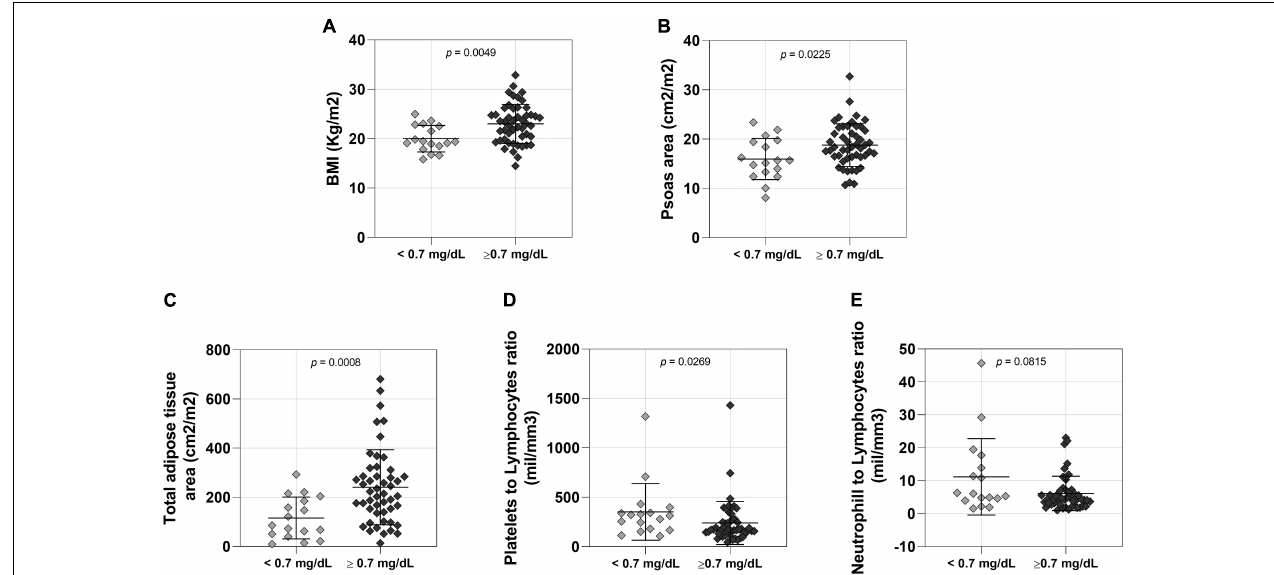
FIGURE 1 | Comparison between lower ( n = 17 < 0.7 mg/dL) and normal ( n = 49 > 0.7 mg/dL) creatinine level male patients. (A) BMI: body mass index; < 0.7 mg/dL 57.53 ± 9.234 (mean ± SD), > 0.7 mg/dL 67.37 ± 13.03 (mean ± SD); 95% CI 0.9478–5.077. (B) Psoas area ; < 0.7 mg/dL 15.96 ± 4.187 (mean ± SD), > 0.7 mg/dL 18.79 ± 4.340 (mean ± SD); 95% CI 0.4132–5.2520. (C) Total adipose tissue ; < 0.7 mg/dL 116.0 ± 85.25 (mean ± SD), > 0.7 mg/dL 240.9 ± 152.5 (mean ± SD); 95% CI 43.50–172.6. (D) Platelets to lymphocytes ratio ; < 0.7 mg/dL 353.2 ± 286.7 (mean ± SD), > 0.7 mg/dL 240.4 ± 217.9 (mean ± SD); 95% CI –164.9 to –7.320 (E) Neutrophill to lymphocytes ratio ; < 0.7 mg/dL 11.17 ± 11.60 (mean ± SD), > 0.7 mg/dL 6.132 ± 5.229 (mean ± SD); 95% CI –6.080 to 0.2500.